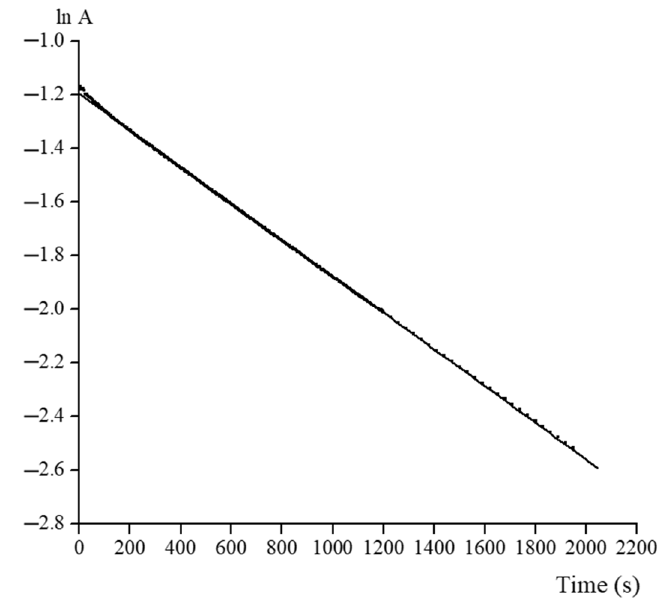
for the k for the ef f eff